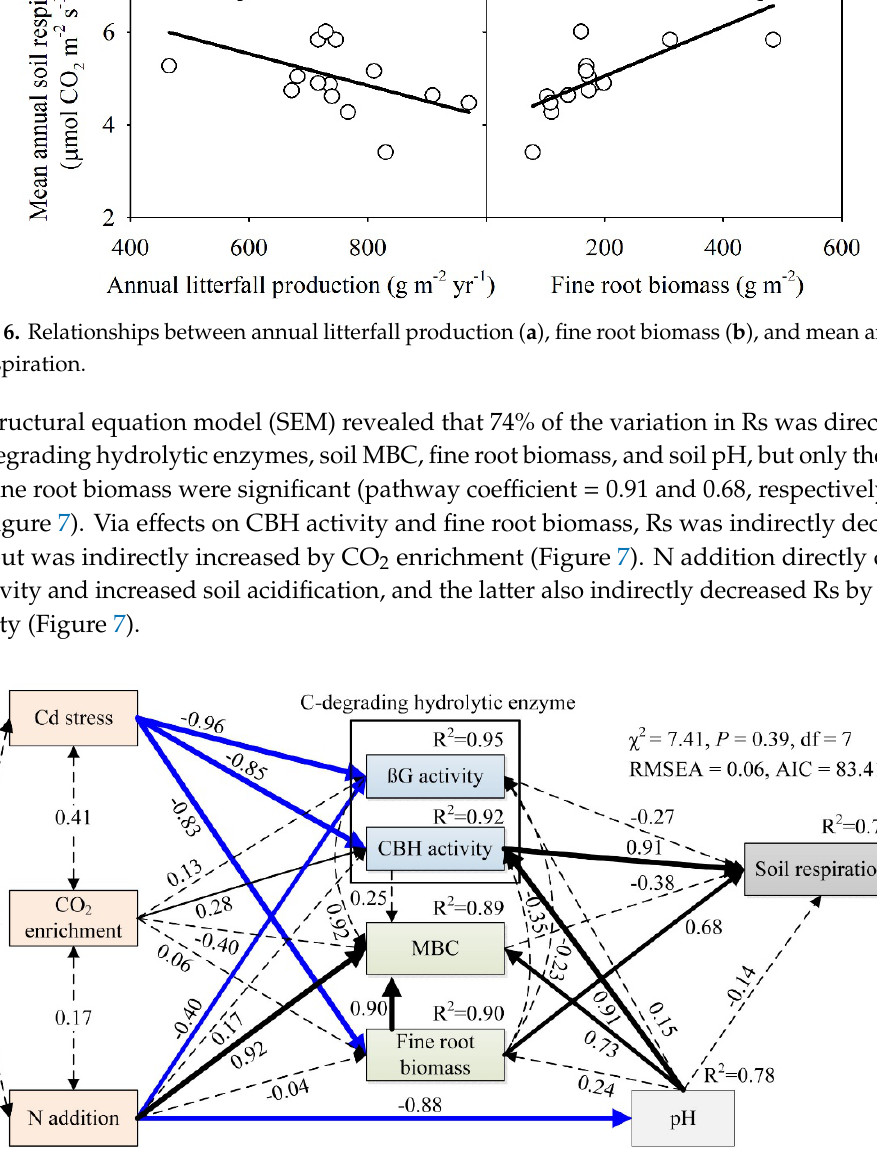
Figure 7. Structural equation model (SEM) for soil respiration under Cd stress, CO 2 enrichment, and N addition treatments using data from the summer. Arrows indicate the hypothesized direction of causation, and the arrow width is proportional to the strength of the path coefficients. Black and blue solid arrows represent significant positive and negative pathways, respectively, and black dashed arrows indicate non-significant pathways. Numbers at arrows are standardized path coefficients. R 2 values above response variables indicate the proportion of variation explained by relationships with other variables. RMSEA: root mean square error of approximation, AIC: Akaike information criteria.